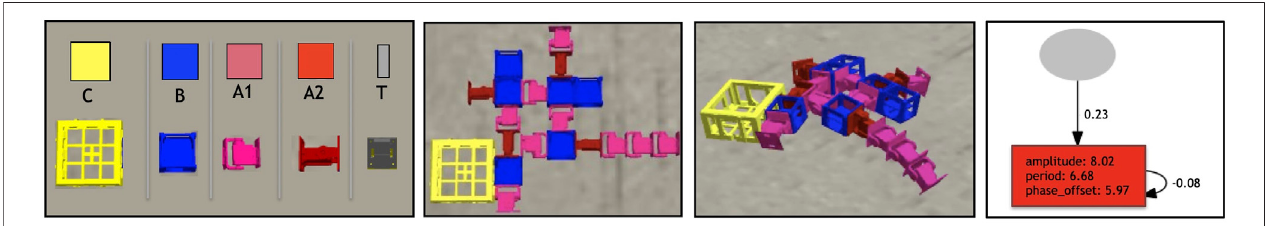
FIGURE 1 | In the fi rst box, the robot modules: Core-component, which carries the controller electronic board (C); Structural brick (B); Active hinges with servo motor joints in the vertical (A1) and horizontal (A2) axes; and Touch sensor (T). The polygons above the pictures of the modules are used to illustrate robot parts in the resultssection,andthelettersareusedtorepresentthemodulesintherobotencoding.ModulesCandBhaveattachmentslotsontheirfourlateralfaces,andA1andA2 have slots on their two opposite lateral faces; T has a single slot, which can be attached to any slot of C or B. In the second box, an exampleof a robot (top-down view) beforethesimulationstarts,whileinthethird,thesamerobotduringasimulation.Inthe fi nalboxanexampleofacontrollerofarobotthathasasinglesensoranda single joint: the network controller has a single oscillator neuron (with a recurrent connection), and a single input.